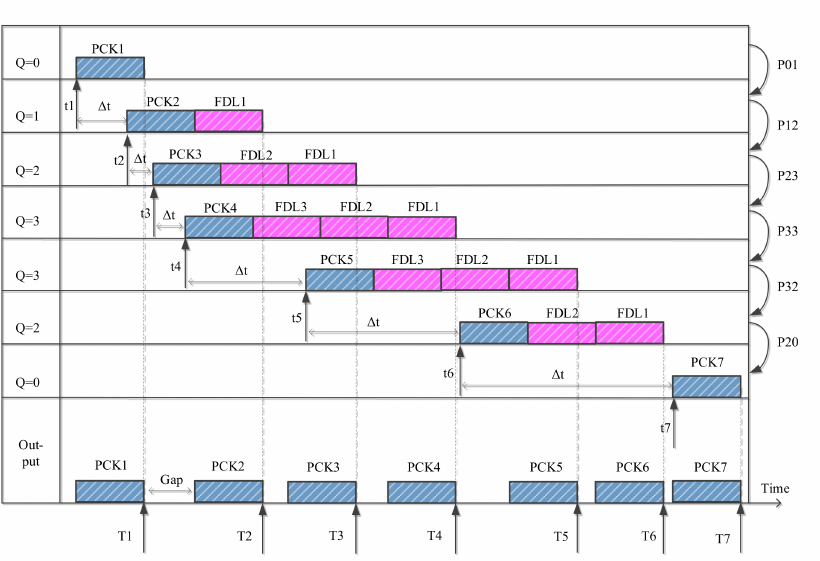
Figure 3. An example timing diagram of the packet departure process from the studied concentra- tor